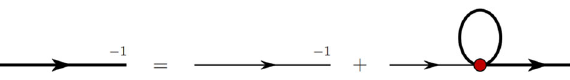
Fig. 1 The NJL gap equation in the Hartree–Fock approximation, where the thin line represents the elementary quark propagator, the shaded circle represents the ¯ qq interaction kernel. Higher-order terms, attributed to meson loops for example, are not included in the gap equa- tion kernel